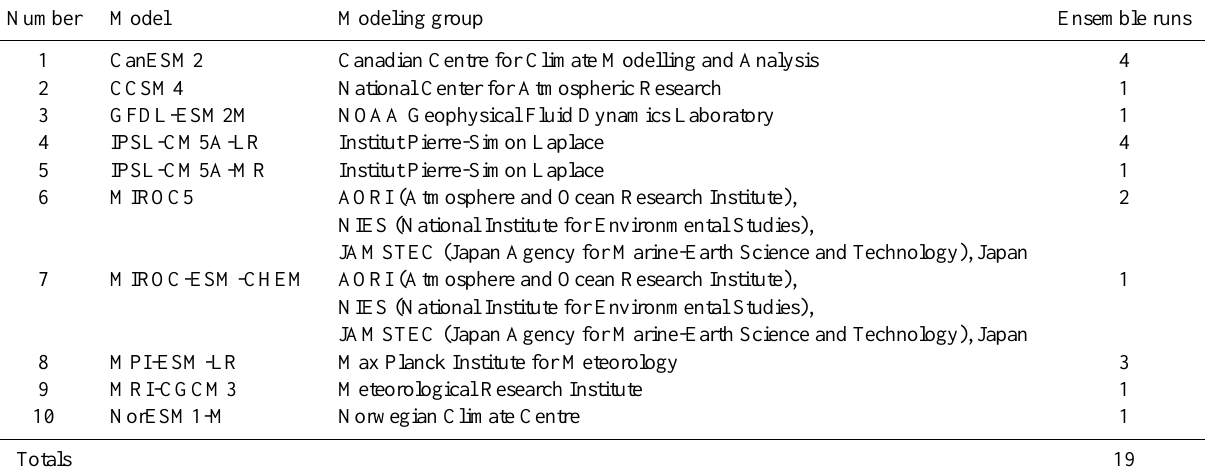
Table 1. The CMIP5 models, modeling groups, and ensemble member(s) used for historical (1981–2005) and RCP8.5 runs (2076–2100) in the